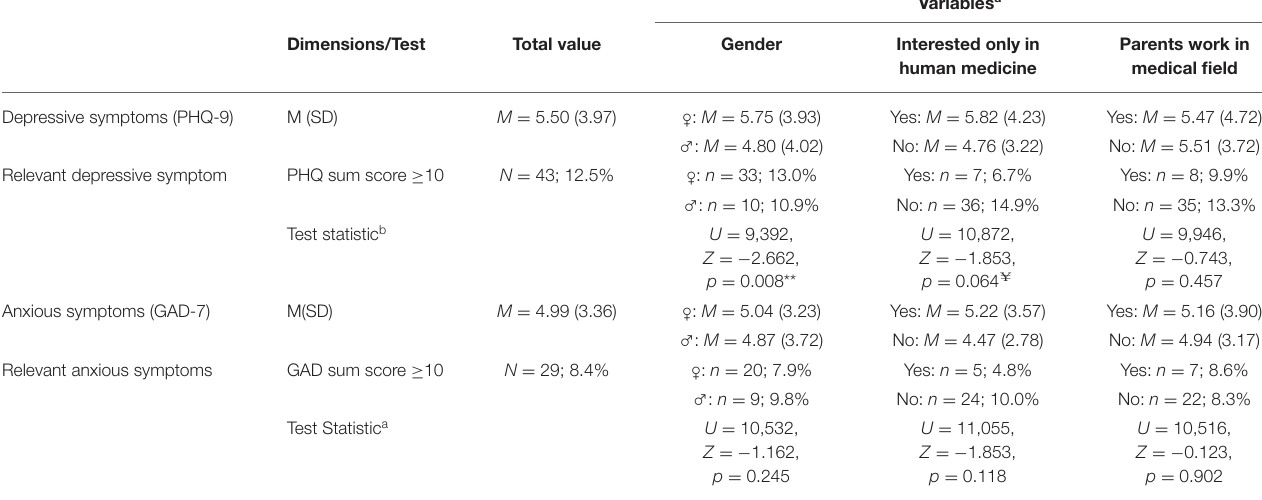
TABLE 3 | Symptoms of depression and anxiety in association to the three additional